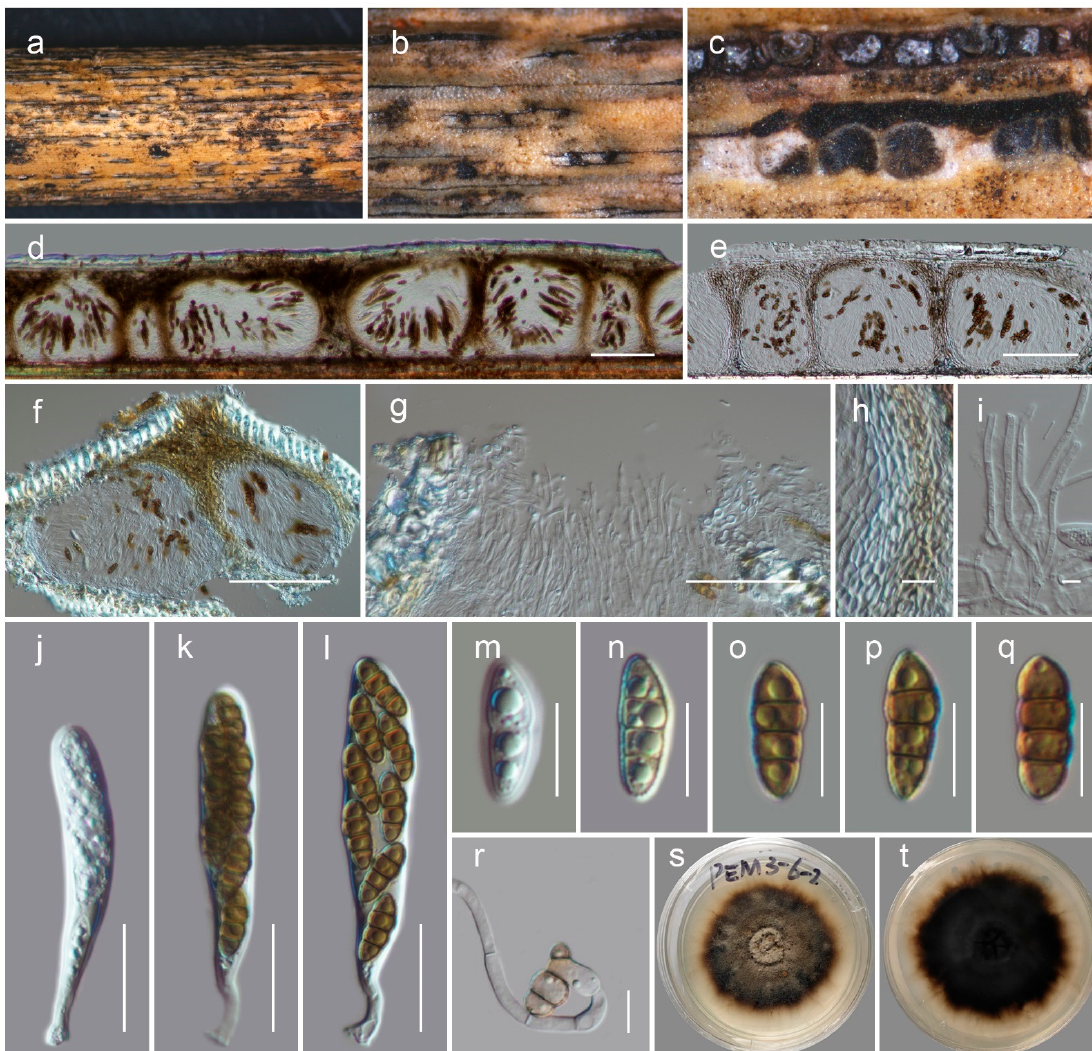
Figure 4. Neokalmusia jonahhulmei (HKAS122910, holotype). ( a , b ) Ascostromata on the bamboo culms; ( c ) horizontal section of ascostromata; ( d , e ) vertical sections of ascomata; ( f ) vertical section through two locules; ( g ) close-up of ostiole; ( h ) peridium; ( i ) pseudoparaphyses; ( j – l ) asci; ( m – r ) ascospores (r germinated ascospore); ( s , t ) colonies on PDA after 21 days. Scale bars, ( d – f ) 100 µ m; ( g ) 50 µ m; ( h , m – r ) 10 µ m; ( i ) 5 µ m; ( j – l ) 20 µ